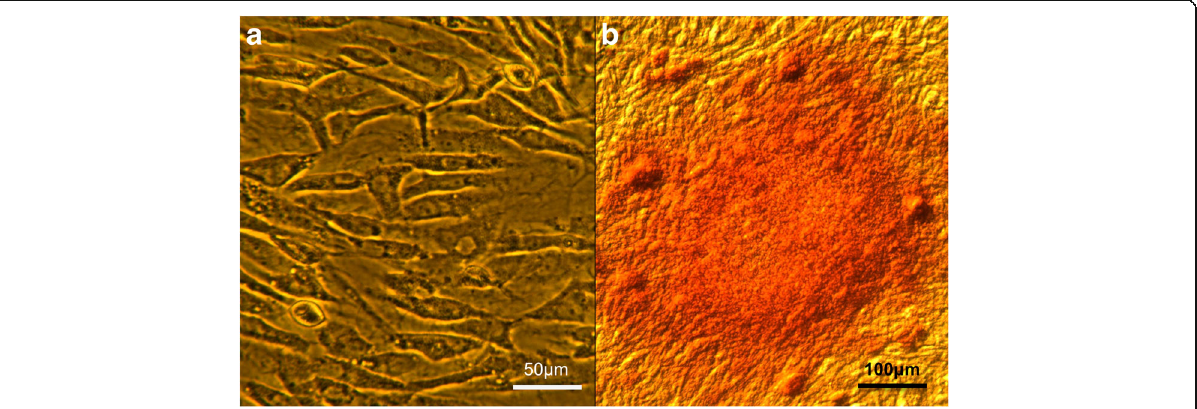
Fig. 2 Photomicrograph of stem cells. Photomicrography demonstrating MSC ( a ) and osteocytes after Von Kossa staining demonstrating the calcium (reddish coloration) ( b )